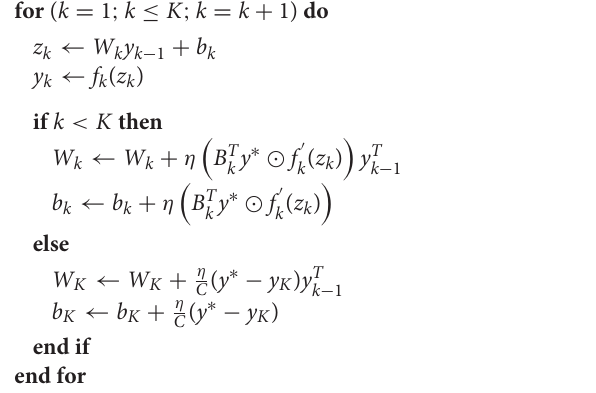
Algorithm 1 : Pseudocode for the direct random target